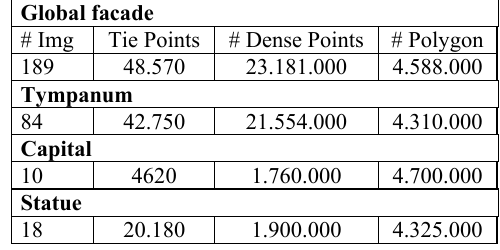
Figure 6. Distinct levels of GCPs recognizability in relation with their façade position.